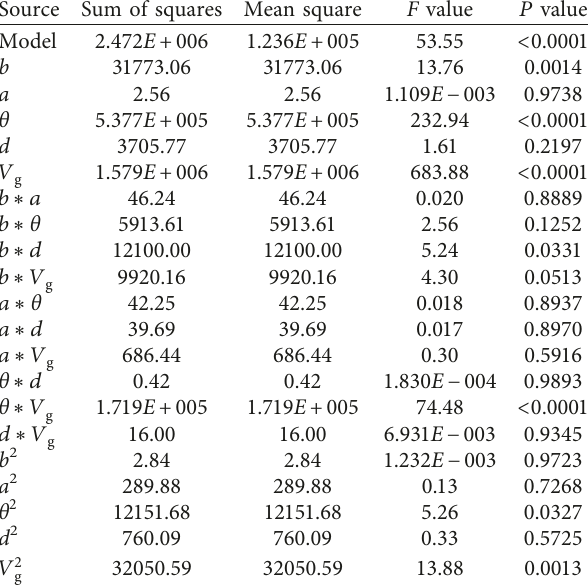
Table 4: Analysis of variance of pressure